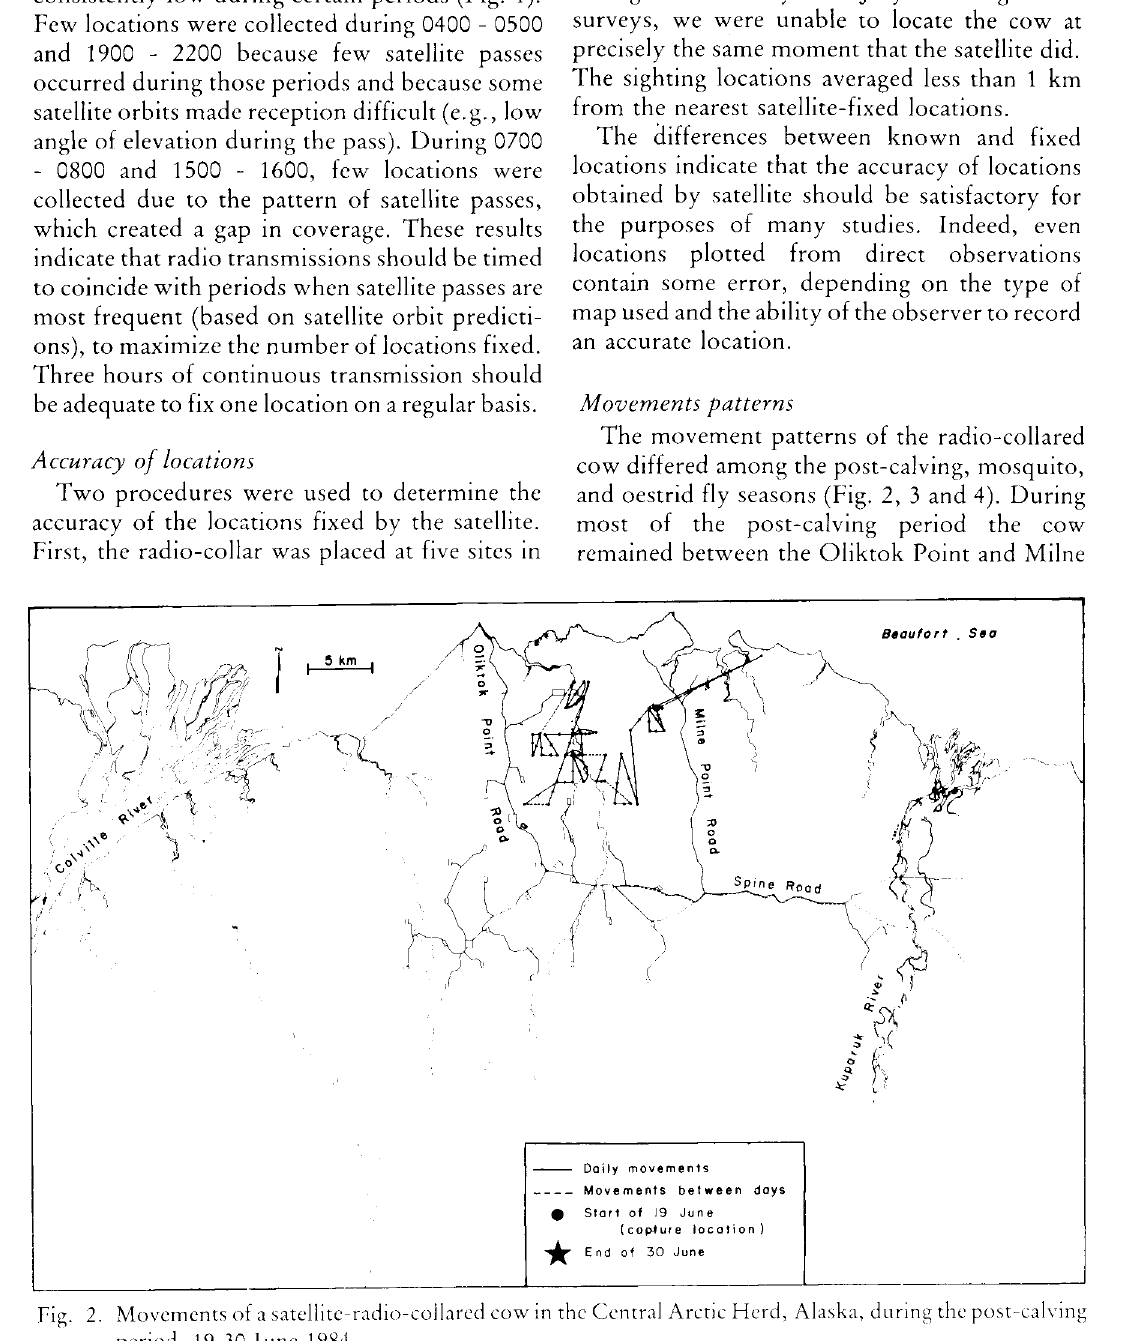
Fig. 2. Movements of a satellite-radio-collared cow in the Central Arctic Herd, Alaska, during the post-calving period, 19-30 June